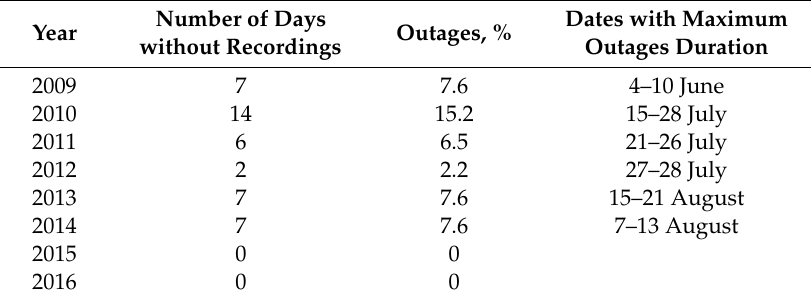
Table 1. Lightning direction finder outages in the summer